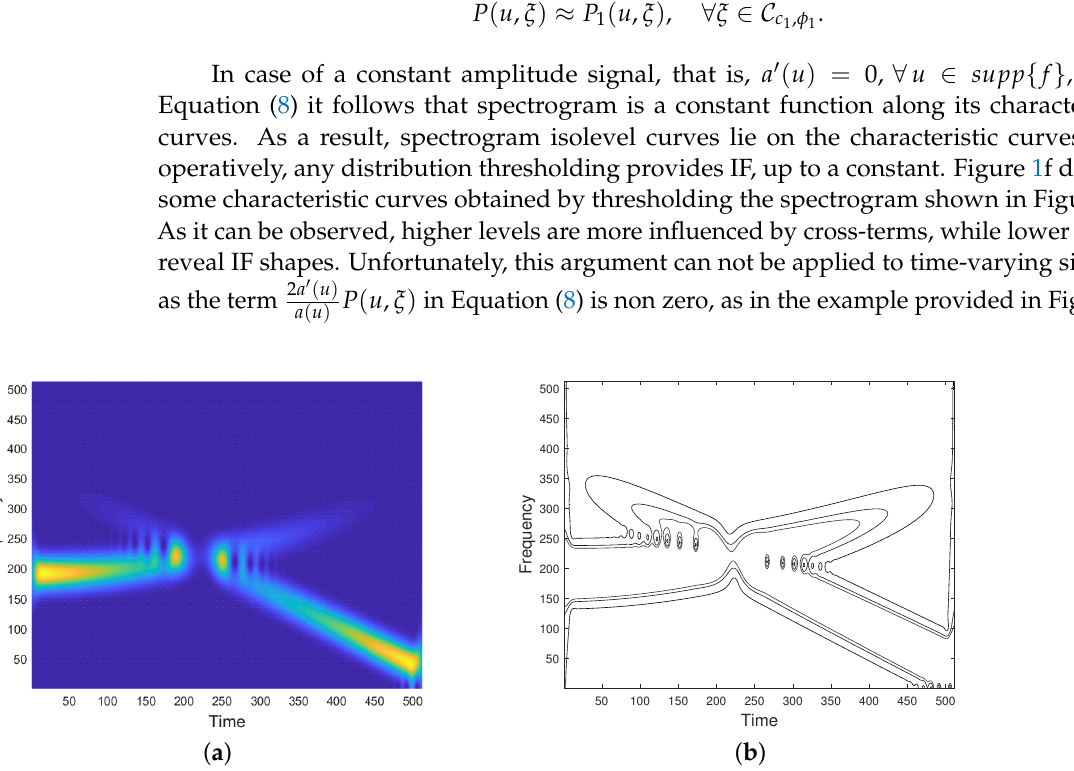
Figure 2. ( a ) Spectrogram of a two-component FM signal with time-varying amplitudes. ( b ) Isolevel